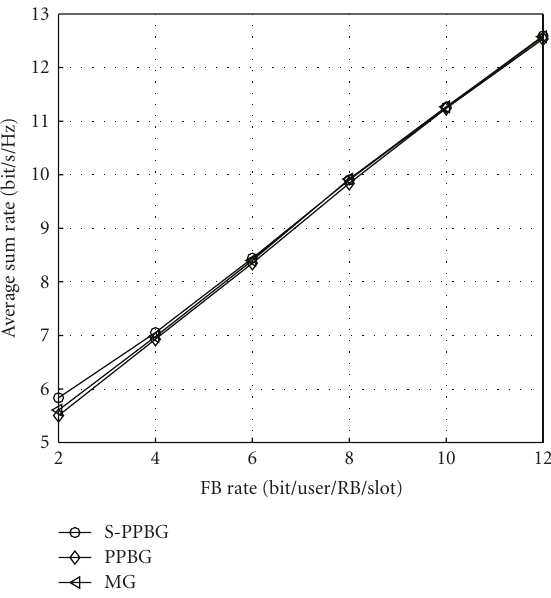
Figure 4: Average sum rate versus per stream feedback rate.